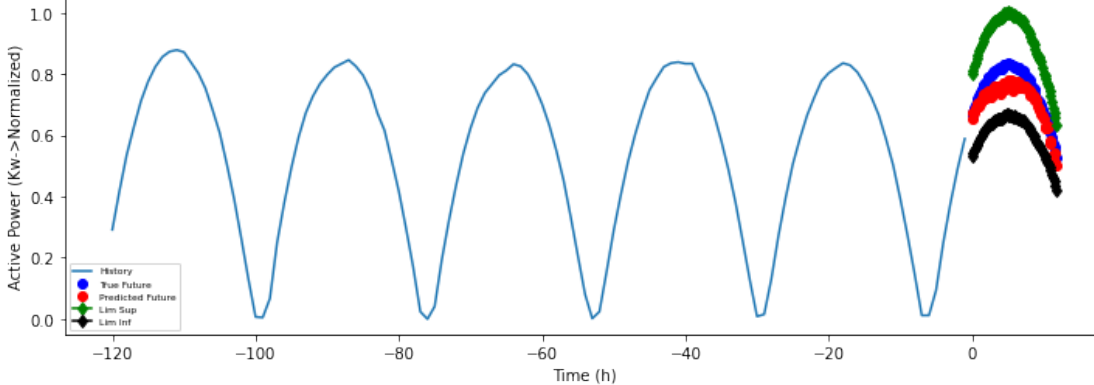
Figure 7. Output power with limit of the solar module in the evaluation window.